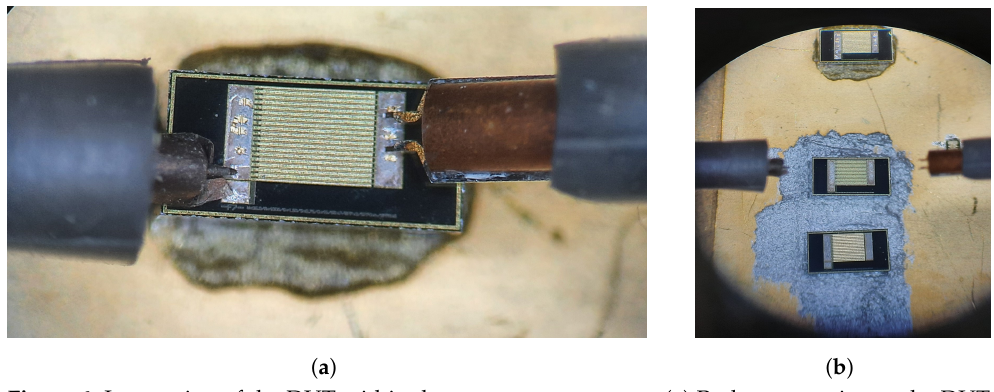
Figure 6. Integration of the DUT within the measurement setup. ( a ) Probe connection to the DUT. ( b ) Three samples (M1, M2, and M3) are placed on the same metal carrier through epoxy with high electrical and thermal